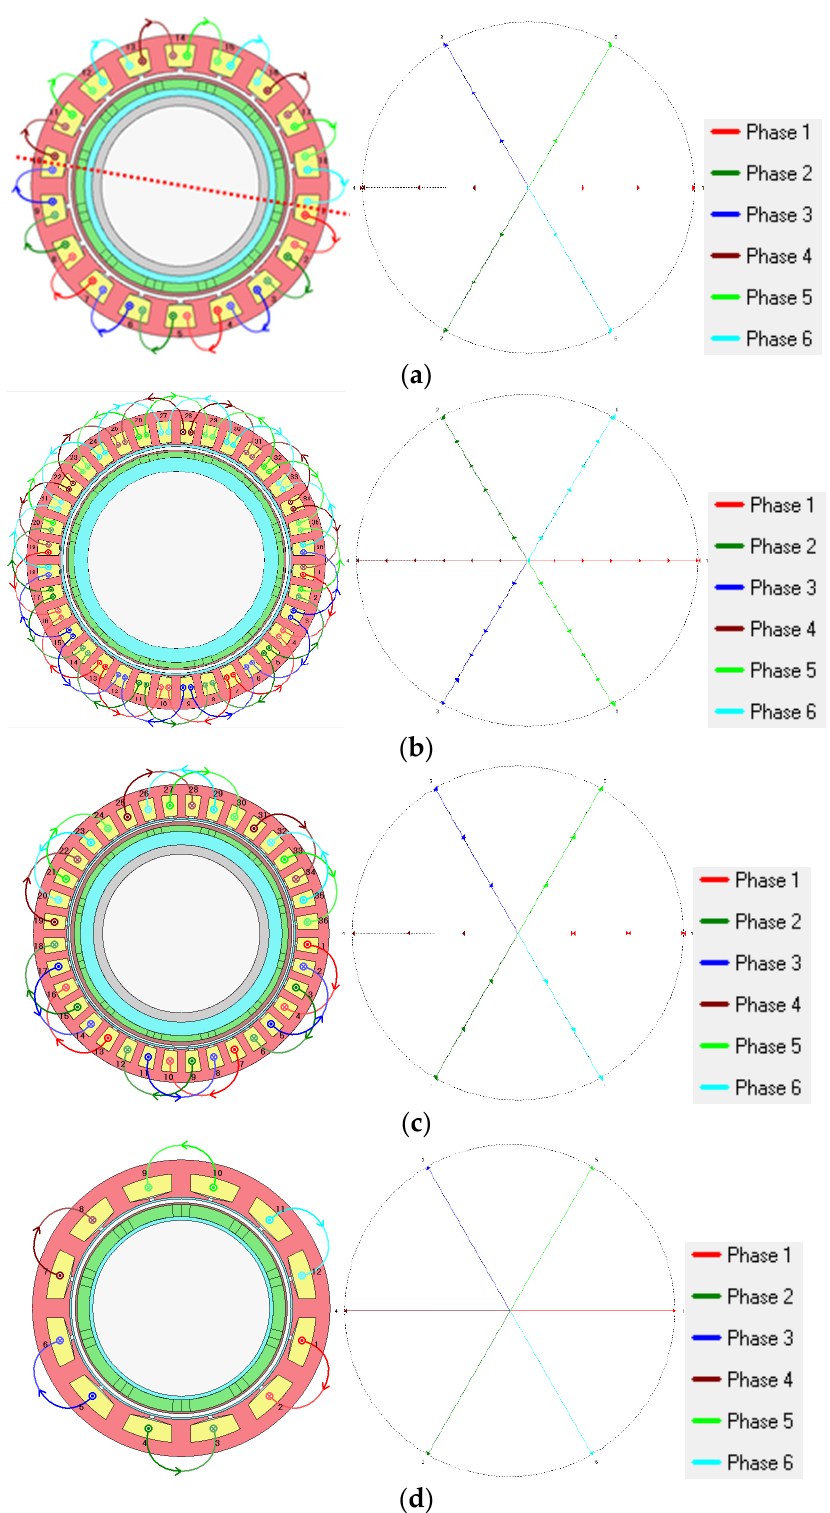
Figure 5. Winding arrangement and phasor diagram of dual three-phase in ( a ) 18 slot/12 pole, double layer (DL); ( b ) 36 slot/12 pole, DL; ( c ) 36 slot/12 pole, single layer (SL); ( d ) 12 slot/10 pole SL.